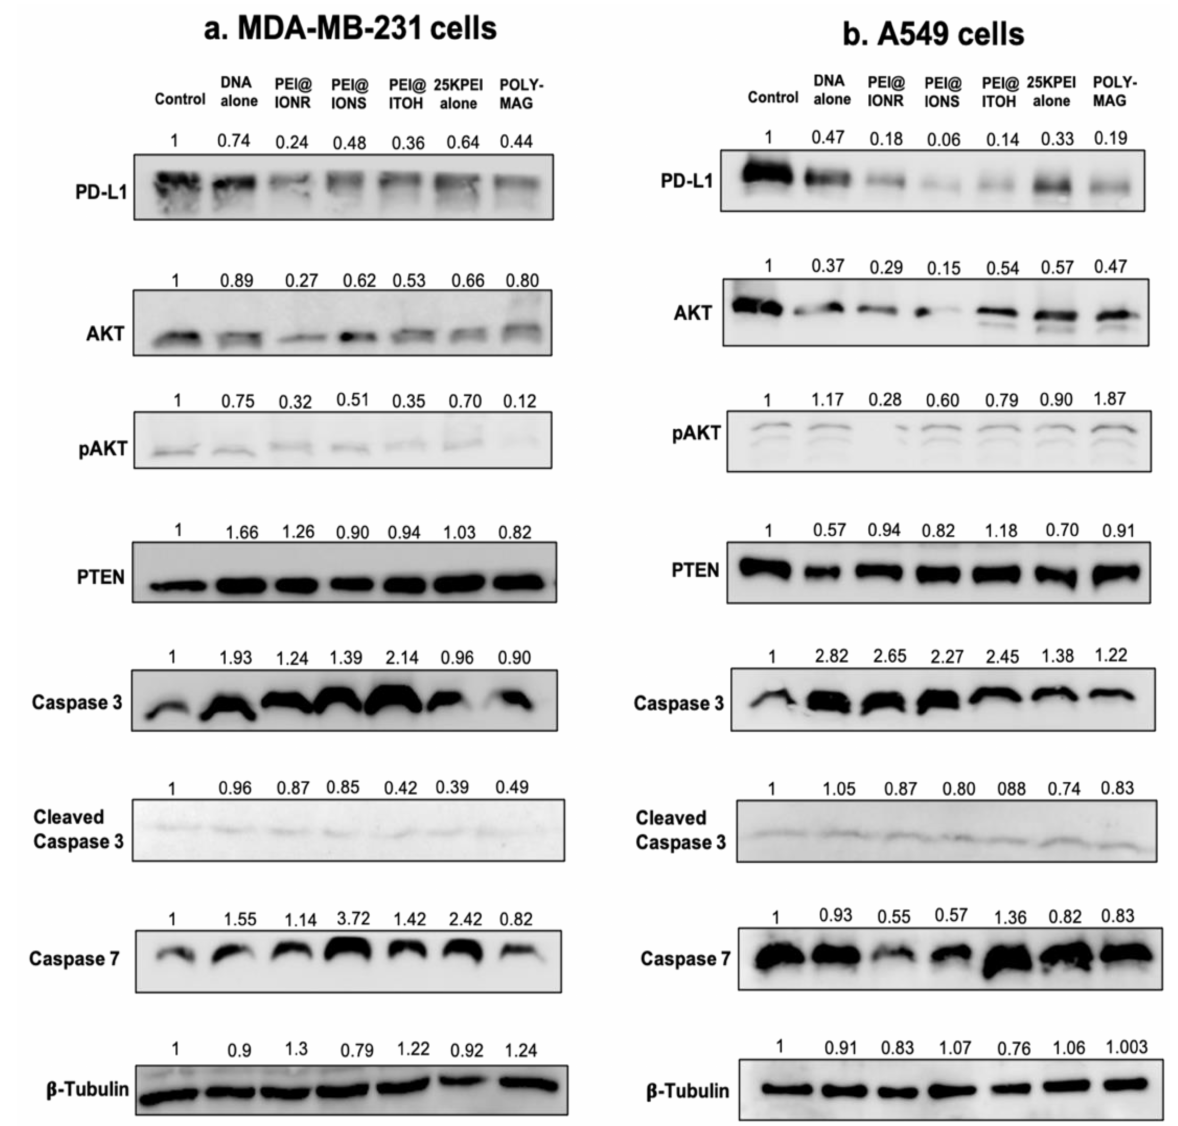
Figure 4. Western blot analysis for PD-L1 protein and its signaling pathways . After transfection with miRNA34a in the ( a ) MDA-MB-231 and ( b ) A549 cell lines, the results show the success and higher percentages of knockdown in PD-L1 protein levels after treatment with PEI@IONPs compared to PEI 25K alone. PD-L1 silencing is also seen with PolyMag treatment, mostly due to the cell cytotoxicity after treatment leading to lower concentrations of protein lysate. The signaling proteins AKT and pAKT are downregulated as they are responsible for promoting and regulating PD-L1 in cancer cells. PTEN is seen to be upregulated as it acts as a tumor suppressor for the PD-L1 gene. The apoptosis markers caspase 3, cleaved caspase 3, and caspase 7 show upregulation after transfection with miRNA34a/PEI@IONPs, inducing apoptosis in cancer cells. Protein expression was analyzed via ImageJ using the fold change